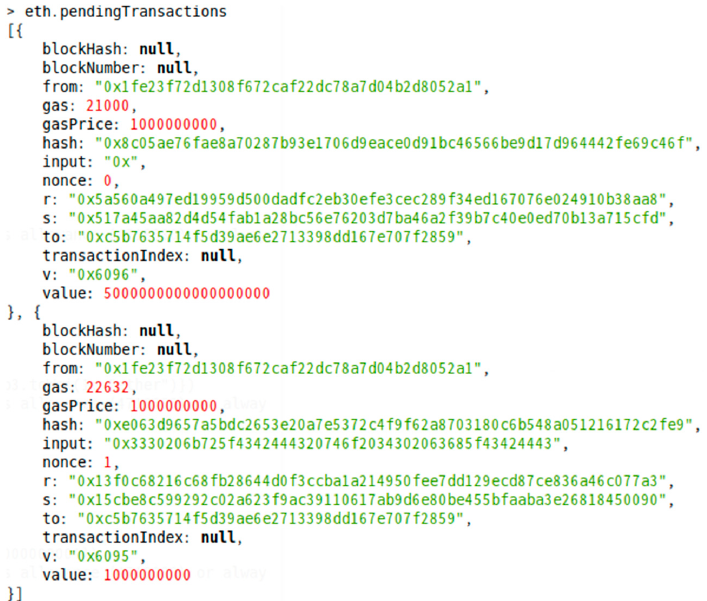
Figure 15. List of transactions stored in the transaction pool in Ethereum.